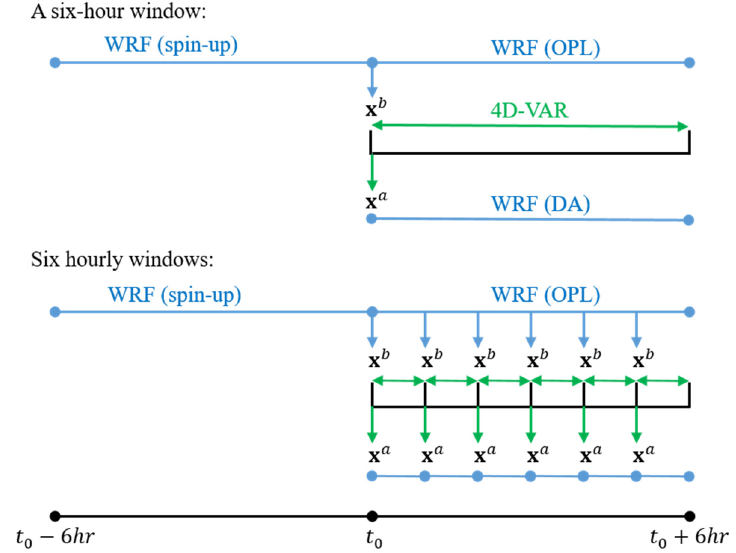
Figure 2. The steps of running open loop (OPL) and data assimilation (DA) experiments with hourly and six-hour assimilation windows.